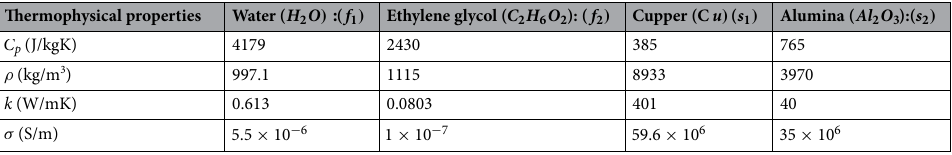
Table 1. Thermophysical properties of base fluids and nanoparticles 27,28